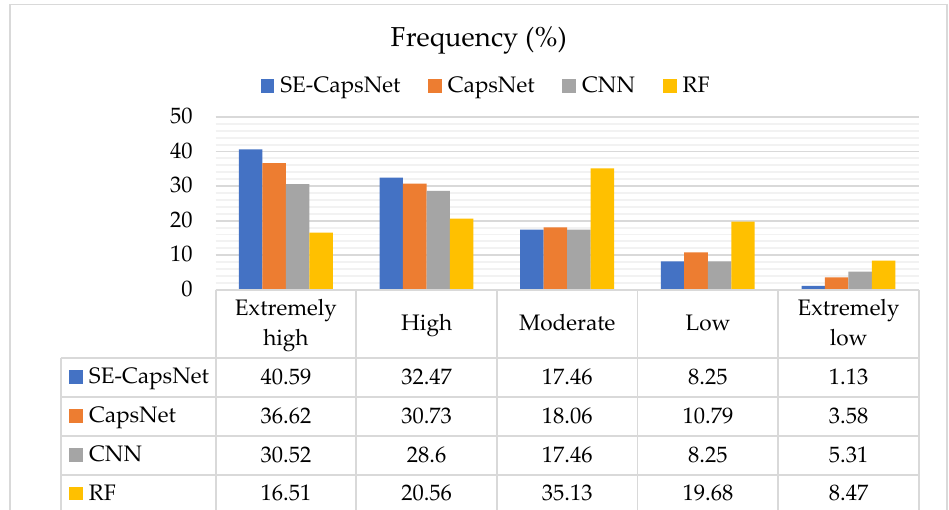
Figure 12. Frequency Based on Various Methods.